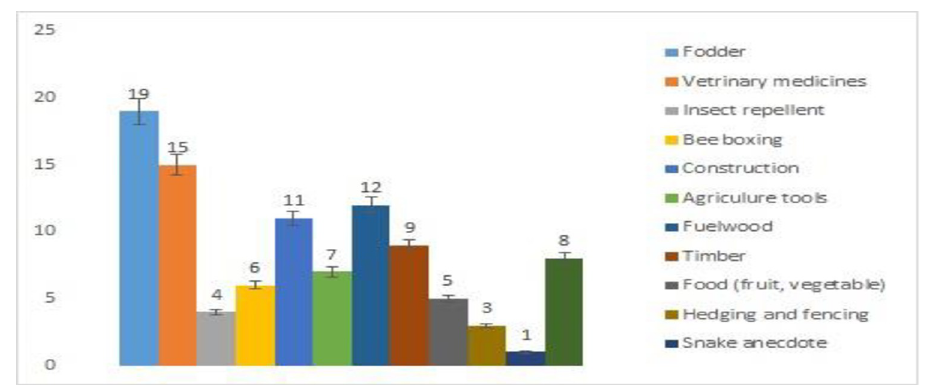
Fig 3. Percentage contribution of different plants for EB/ EM purposes from SMR of District Bhimber AJK, Pakistan.